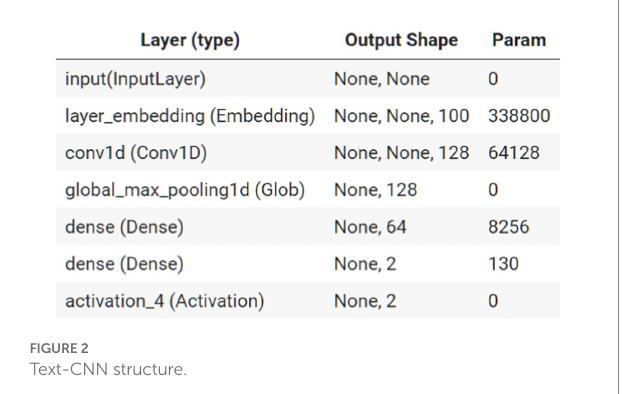
FIGURE 2 Text-CNN structure.